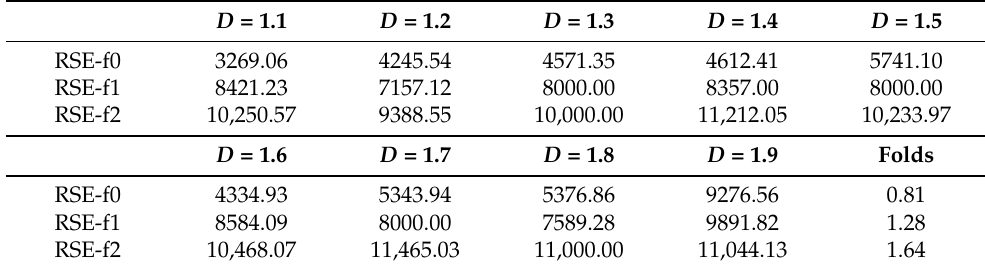
Table 1. The sampling length stabilizing L c data.